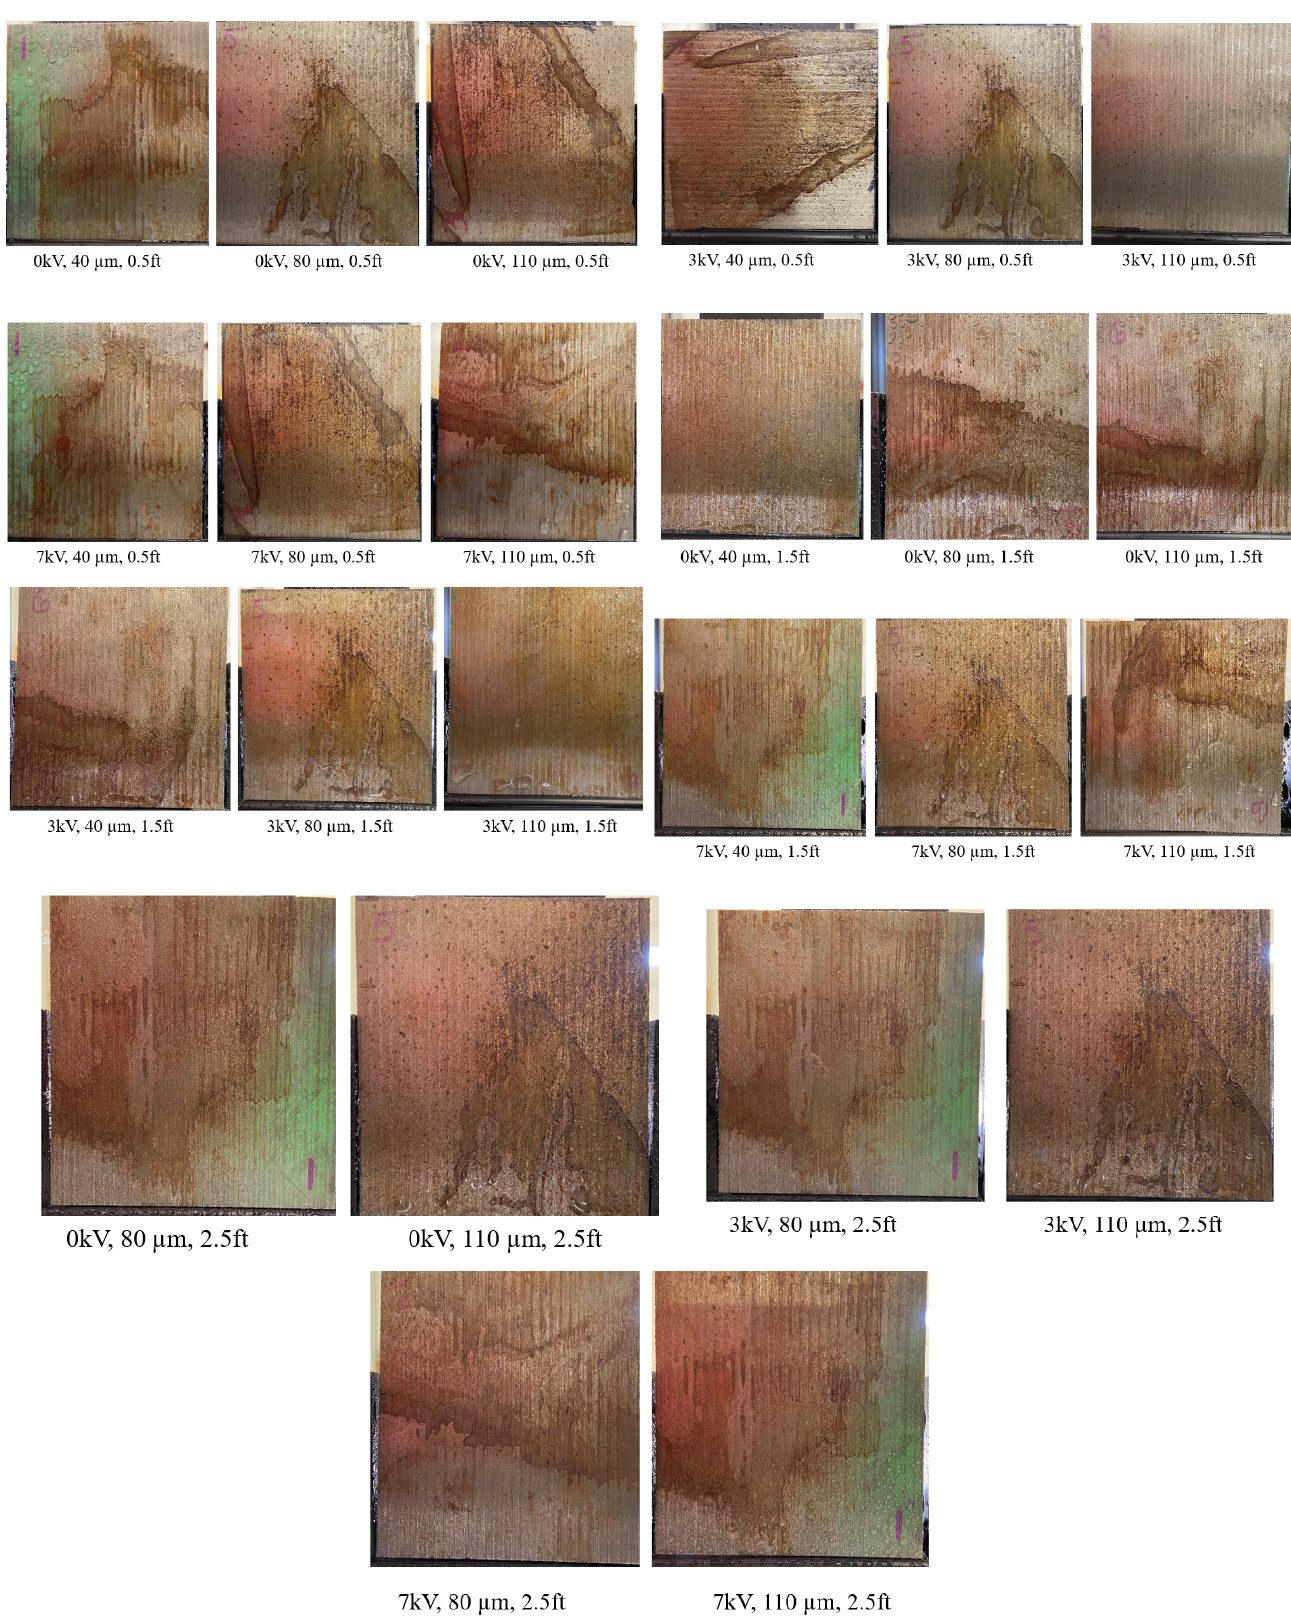
Figure A13. Cast iron: qualitative images of electrostatic deposition under various system